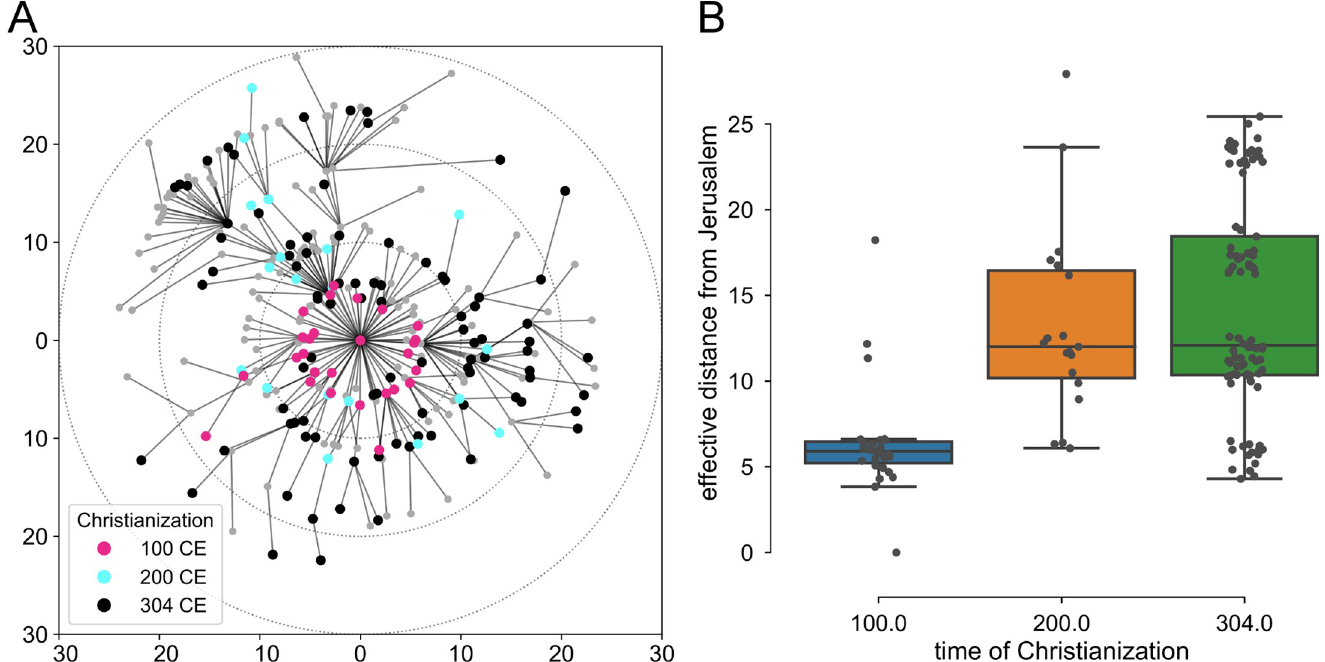
Fig 4. Effective distance from Jerusalem and the time of Christianization. (A) the radial distance is equal to the effective distance, colors correspond to the time of Christianization. (B) the distribution of the effective distance against the time of Christianization. The box shows the median and the quartiles, the whiskers extend past the quartiles by 1.5 interquartile